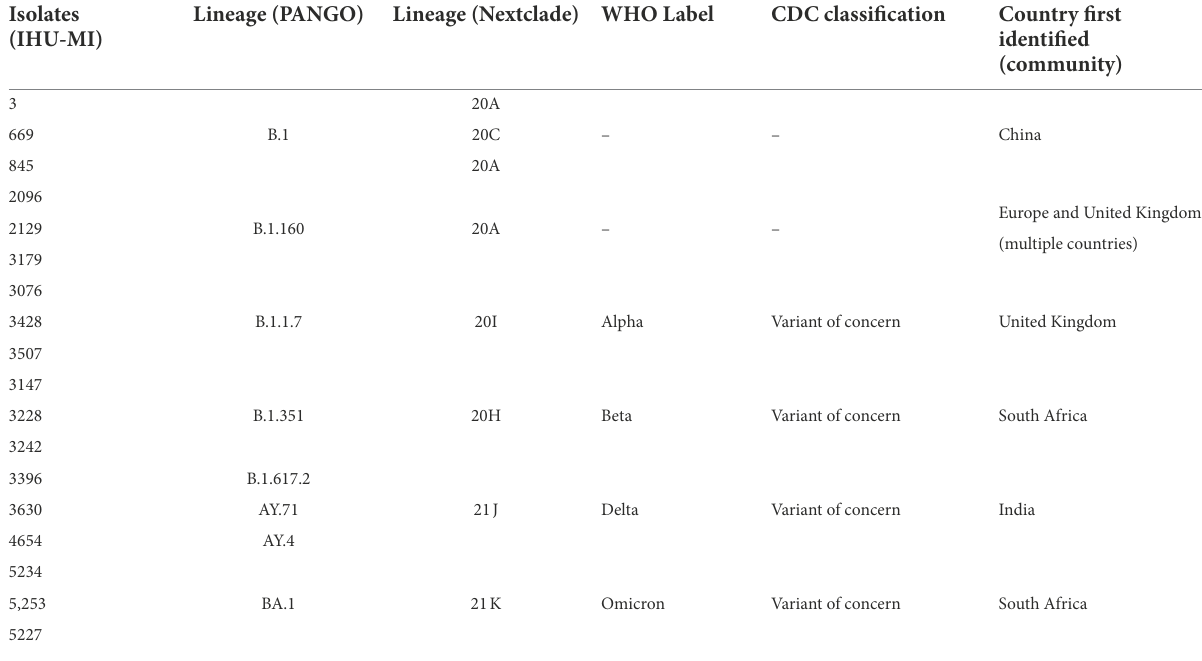
TABLE 1 List of isolated SARS-CoV-2 and their respective genotypes and classifications. Isolates Lineage (PANGO) Lineage (Nextclade) WHO (IHU-MI)